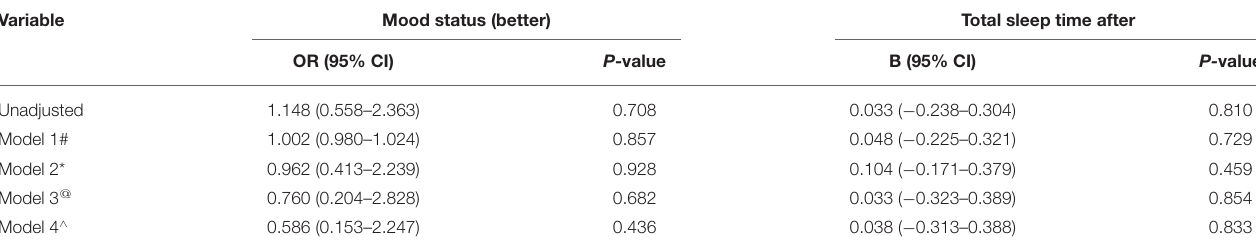
TABLE 3 | Logistic and linear analyses determining the association of females with mood status and total sleep time during the COVID-19 stay-at-home orders.